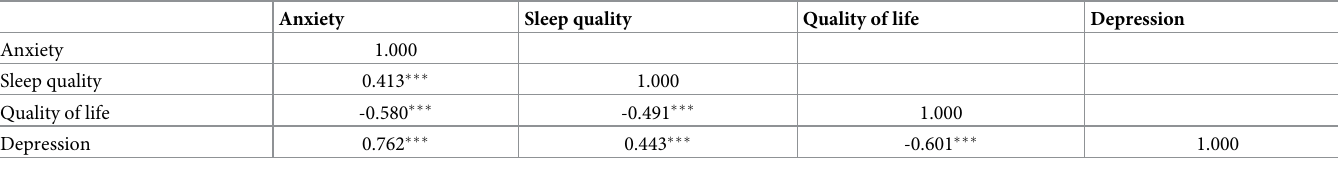
Table 2. Correlations between anxiety, sleep quality, quality of life, and